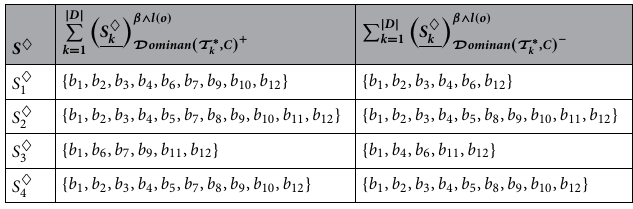
Table 8. The lower approximations with β = 0.90, l = 1